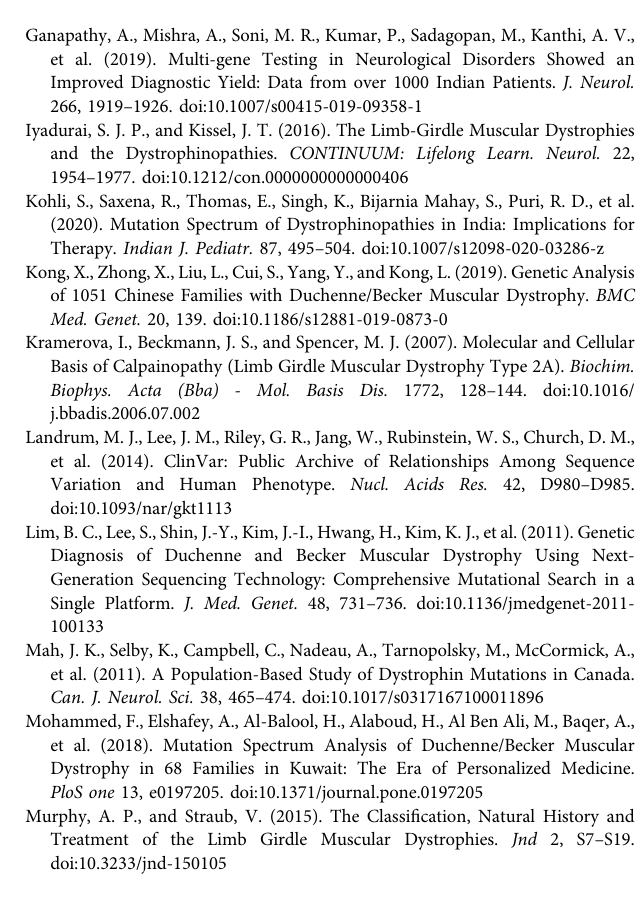
Supplementary Figure S1 | Integrative Genomics Viewer (IGV) snapshot depicting arepresentativeimageofIonReportersoftware (v5.12) CNV analysisresults inDMD gene where red bar showing the deleted region of exon 3-4 in the patient. Supplementary Figure S2 | Integrative Genomics Viewer (IGV) snapshot depicting a representative image of Ion Reporter software (v5.12) CNV analysis results in CAPN3genewhereredbar showingthedeleted